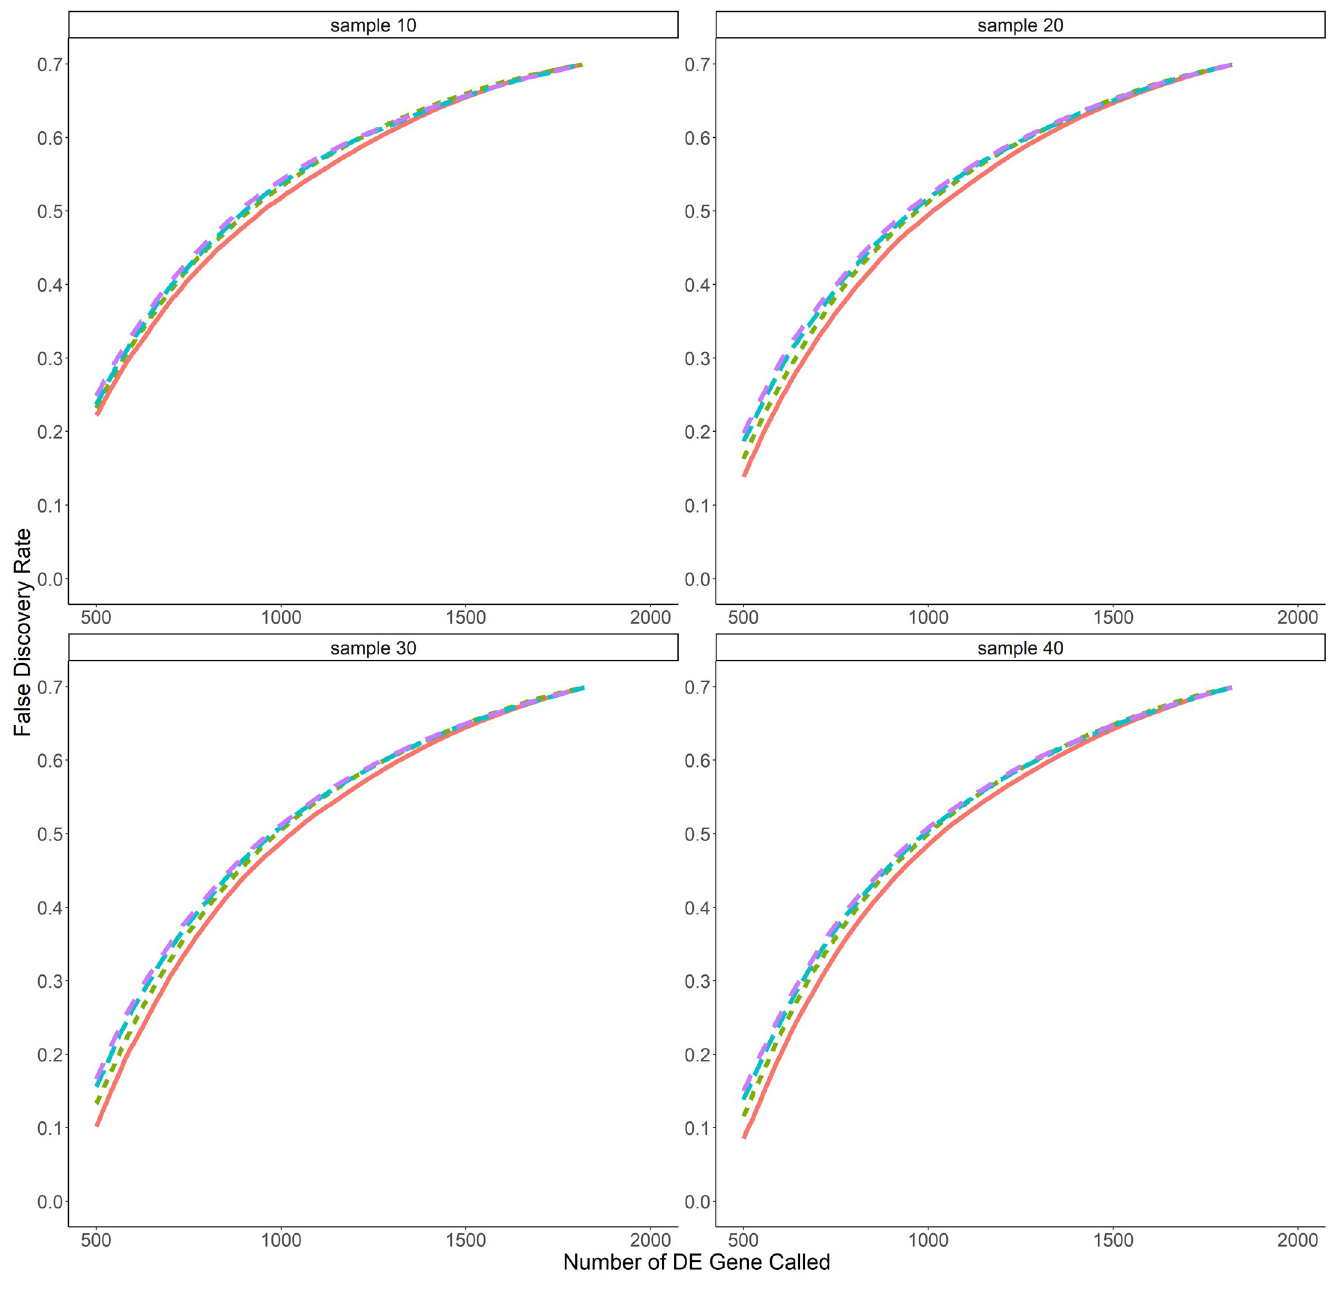
Fig 7. False discovery rate vs. number of DE gene called with large dispersion. Finally, we had a simulation setting to compare the capabilities of SGNB, edgeR and DESeq in detecting isoform-wise expression level change. Among 10 genes, there was 1 DE gene whose total size of isoforms kept unchanged but the isoform-level expression changed. This gene has 2 isoforms. The SGNB with model simplification detected it 100 times during 100 runs, while the edgeR and DESeq detected it only once during 100 runs.